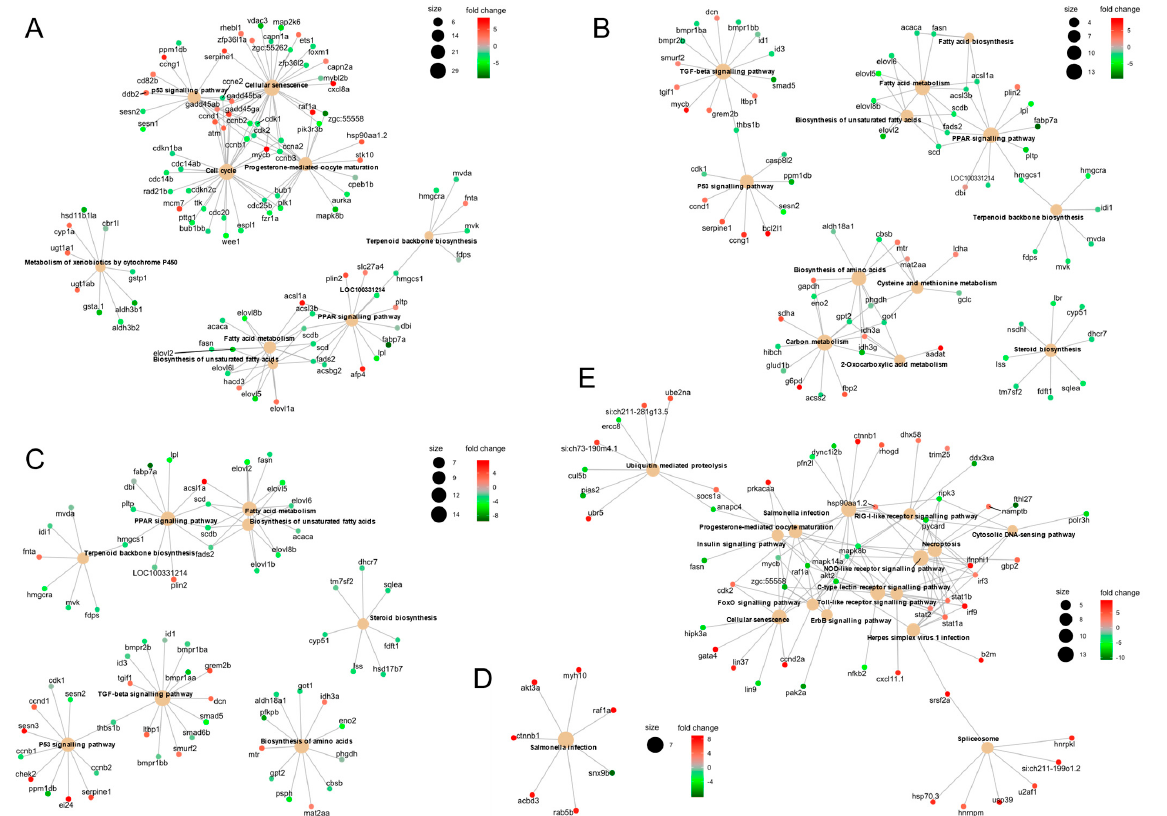
Figure 5. ( A – E ) Gene-concept networks showing genes associated with enriched KEGG pathways in the rainbow trout gonad cell line RTG-2 inoculated with non-pathogenic viral haemorrhagic septicaemia virus (VHSV) (1p49) at 3 h post- inoculation (hpi) ( A ), 6hpi ( B ), and 12hpi ( C ); and pathogenic VHSV (J167) at 3hpi ( D ) and 12hpi ( E ). The sizes of the category nodes (enriched KEGG pathways) are proportional to the number of genes and the colours of the gene nodes represent log2 fold-change (red = up-regulated genes, green = down-regulated genes).